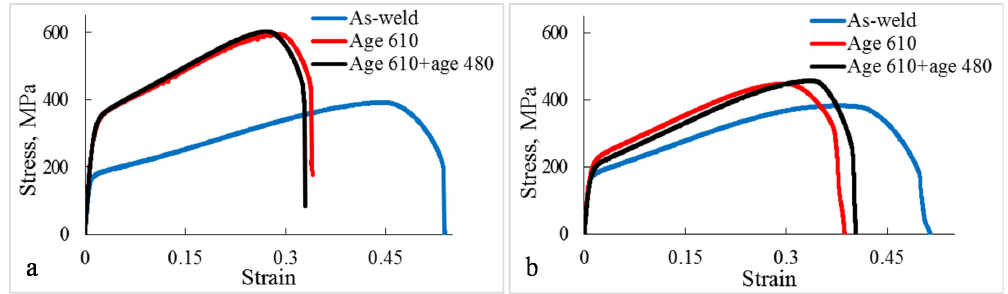
Figure 7. The stress–strain curves of ( a ) Monel K500 and ( b ) FM60 for the torch travel speed of 500 mm/min and various heat treatment